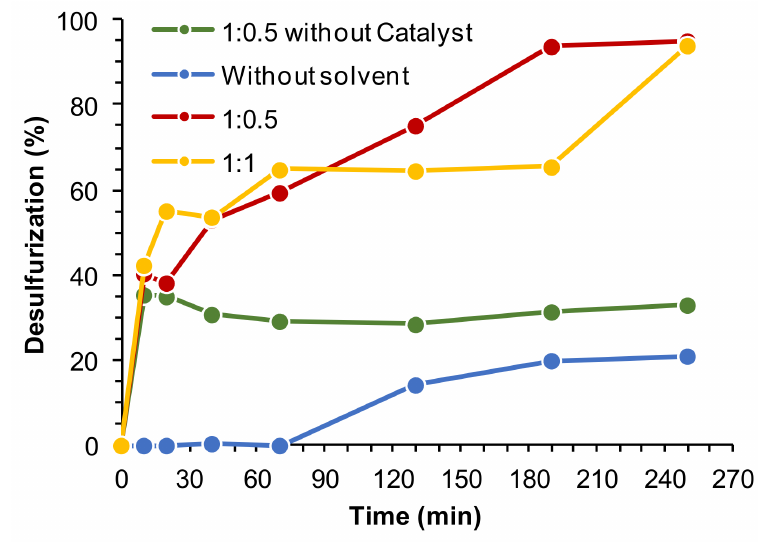
Figure 8. Desulfurization of a multicomponent model diesel (2000 ppm S) catalyzed by UAV- 59@PMMA membrane (containing 0.02 mmol Gd), using 0.64 mmol of H 2 O 2 as oxidant, different volume of extraction solvent (1:1 and 1:0.5 diesel/[BMIM]PF 6 ) and for a solvent-free system, at 70 ◦